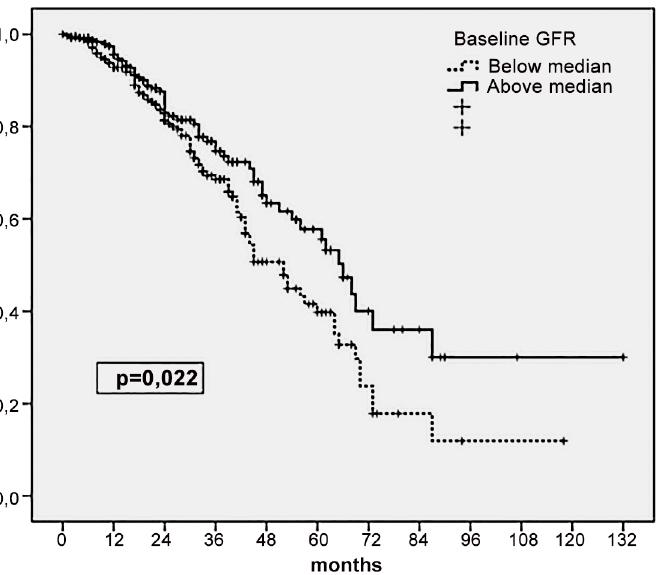
Fig 2. Patient survival according to baseline GFR, categorized from median value. Kaplan Meier plot (log rank).